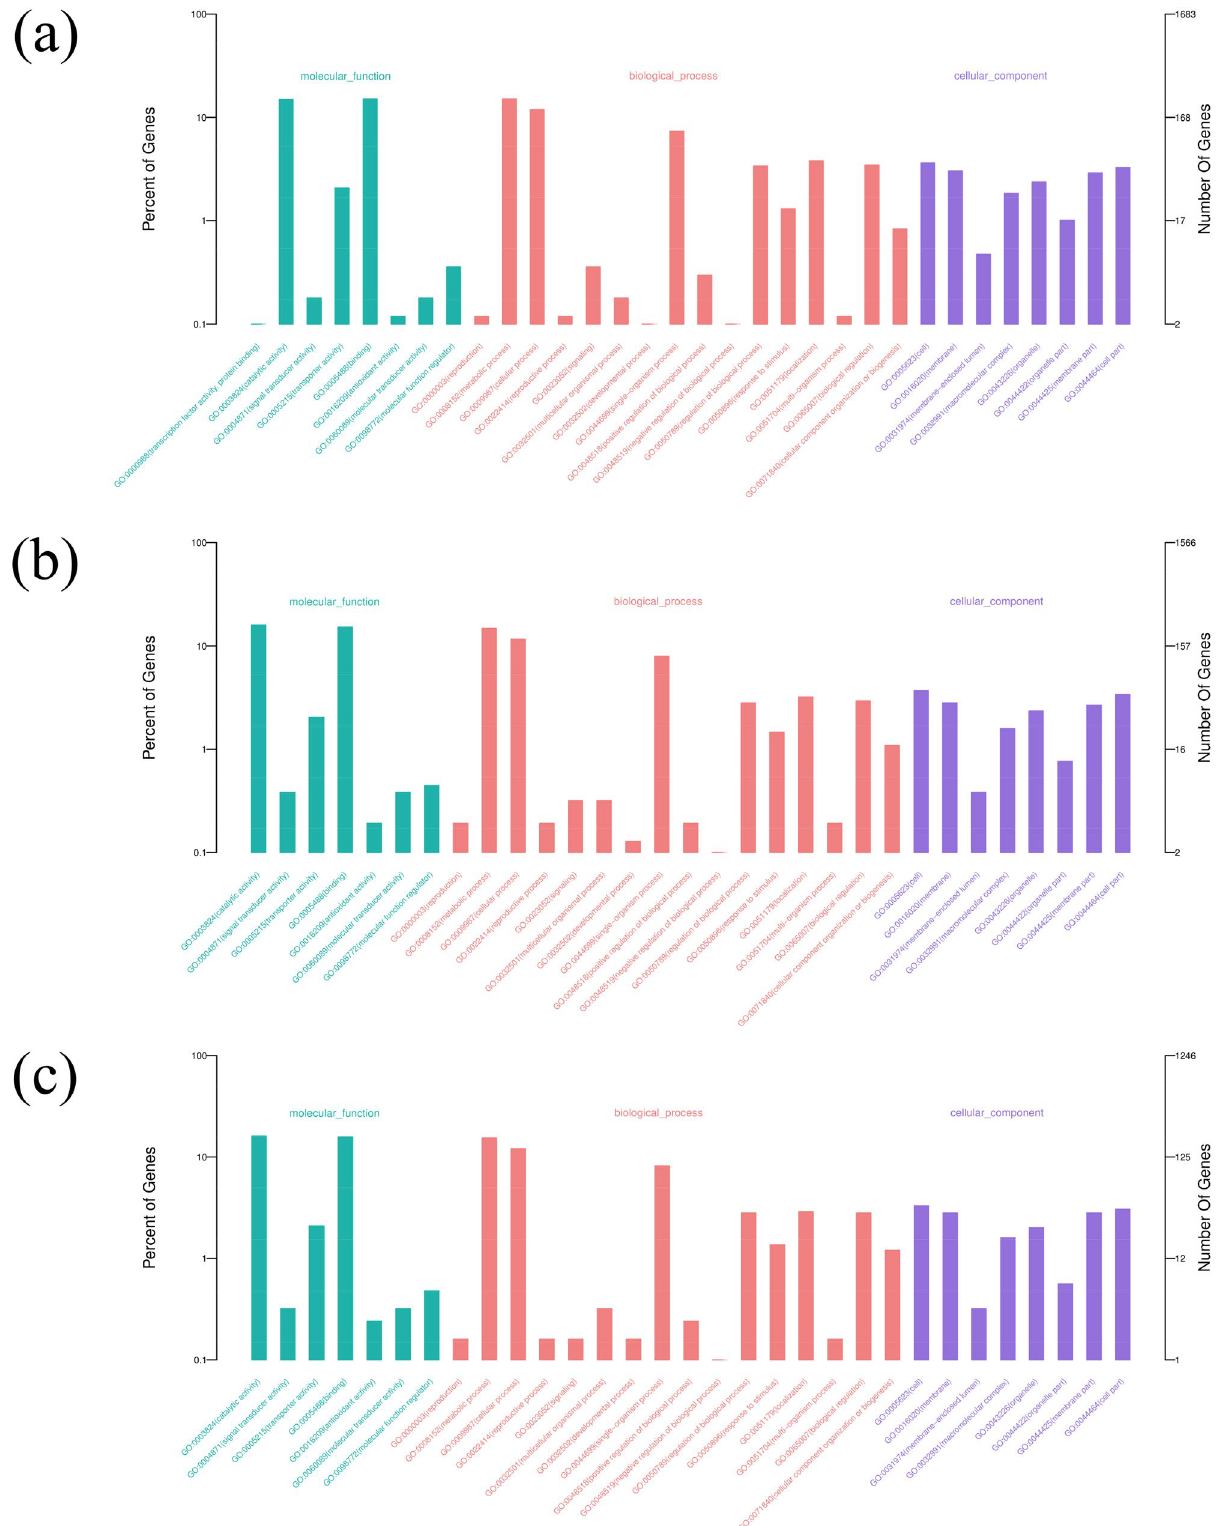
Figure 5. Functional annotation analysis of DEGs was conducted according to GO terms. ( a ) Enriched GO terms in 7 DPA fiber vs. nonfiber tissues; ( b ) enriched GO terms in 14 DPA fiber vs. nonfiber tissues; ( c ) enriched GO terms in 26 DPA fiber vs. nonfiber